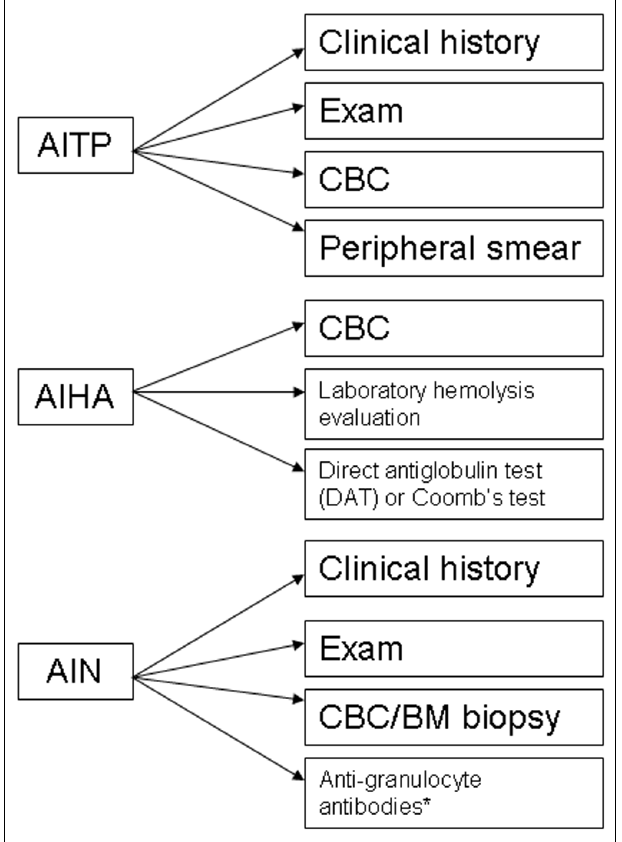
FIGURE 1 | Diagnostic algorithm for autoimmune cytopenias in CVID. AITP, autoimmune thrombocytopenia purpura; AIHA, autoimmune hemolytic anemia; AIN, autoneutropenia; IVIG, intravenous immunoglobulin;.